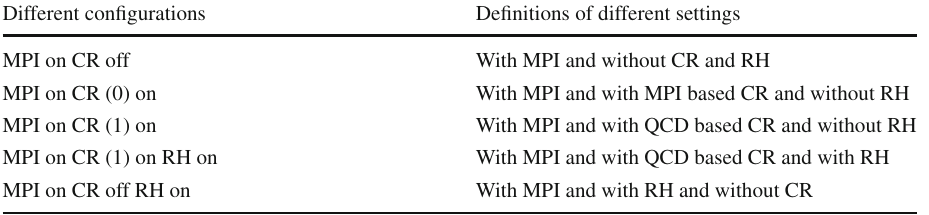
Table 1 A list of different configurations (processes) used in Pythia 8 for the analysis. MPI, multi-partonic interactions; CR,